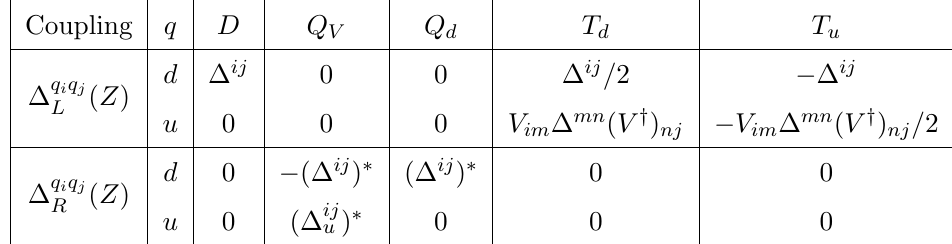
Table 3. (cid:1) q i q j ( Z ) for down- and up-type-quark couplings ( i; j = 1 ; 2 ; 3) to the Z boson in G SM - L;R models. Here V ij is the CKM matrix and (cid:1) u = (cid:1)( (cid:21) V d